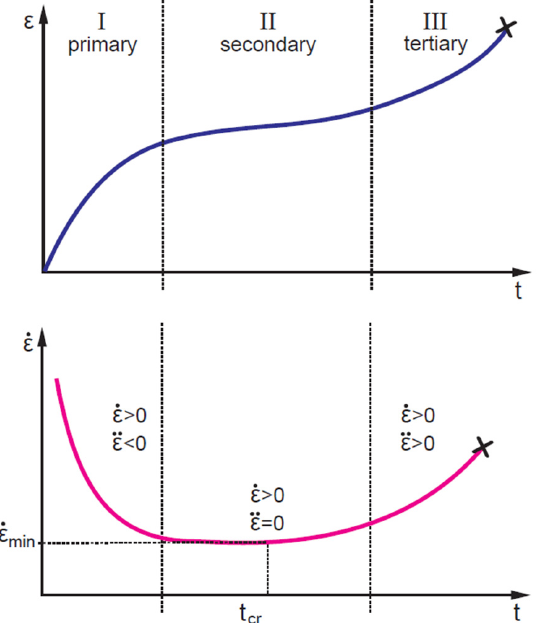
Figure 7. Typical creep curves: evolution of strain ( top ) and strain rate ( bottom ) with time. Failure is an unstable process related to the microstructural specificity of a sample and testing conditions [31,80]; thus, failure predictions should be based on an extensive experimental data set and statistical analysis [113]. At the same time, in most applications, materials are exploited in the secondary creep regime, while tertiary creep is undesirable and considered the overshoot of the safety intervals [76]. Thus, many approaches consider the transition from the secondary to tertiary creep stage as a limiting factor or failure cri- teria defined by the strain rate minimum (Figure 7), for instance, the creep failure time model developed by Spathis and Kontou [31] and Monkman–Grant parametrisation [75,114] (see also Section 2.4). Strain rate minima are determined from the strain rate vs. strain dependences called Sherby–Dorn plots [69,70,112]. As examples, Sherby–Dorn plots for glass-fibre reinforced isostatic polypropylene (iPP) [72] and carbon nanotube (CNT) reinforced polycarbonate [69] composites tested in uniaxial creep at 23 °C under various stresses are shown in Fig- ure 8. It is seen that positions of strain rate minima increase with growing stress levels. Figure 8. Sherby–Dorn plots for ( a ) glass-fibre reinforced iPP composites [72], and ( b ) polycar- bonate/CNT composites [69], tested in uniaxial creep at 23 °C under various stresses.